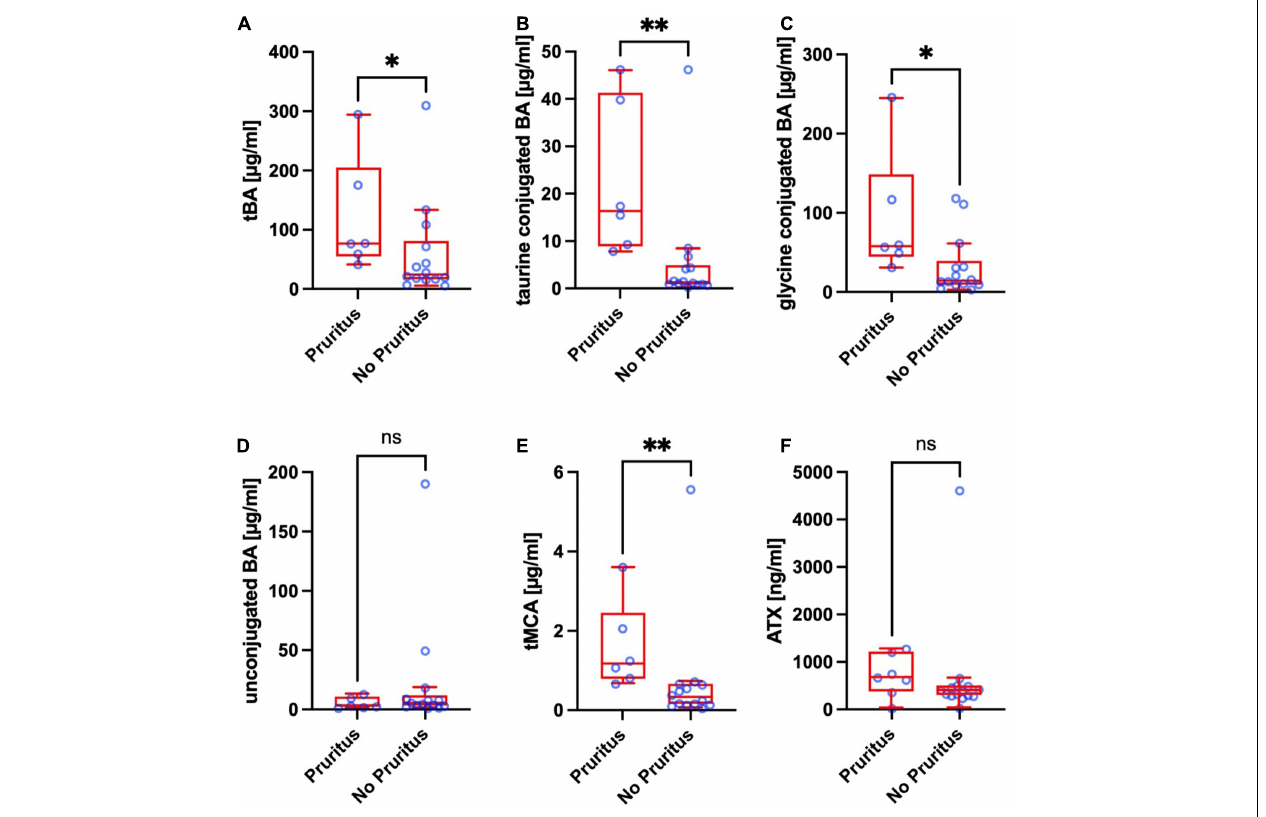
FIGURE 2 | Total bile acids (tBA) (A) , taurine conjugated BA (B) , glycine conjugated BA (C) , unconjugated BA (D) , total muricholic bile acids (tMCA) (E) , and autotaxin (ATX) antigen levels (F) of pediatric ASC patients with and without pruritus. Significances are indicated with bars and stars within the diagram. ∗ p < 0.05; ∗∗ p <